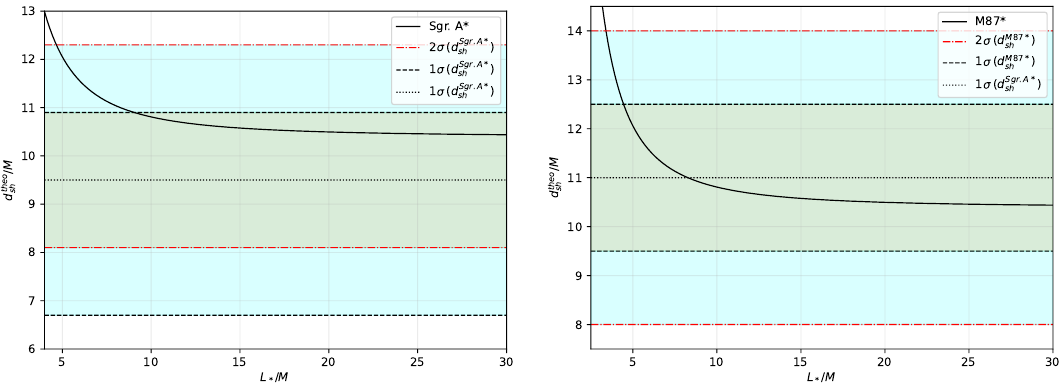
Figure 1. Observational contraints for the M -normalized theoretical shadow diameter for var- ious M -normalized fundamental length scales, L ∗ , for black holes Sgr. A* and M87*, where M is the black hole mass.